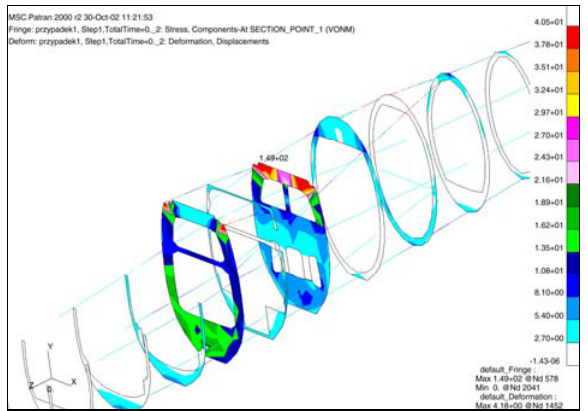
Fig 15. Effective stress distribution (von Misses) in fuselage carrying frames in fuselage – wing joints